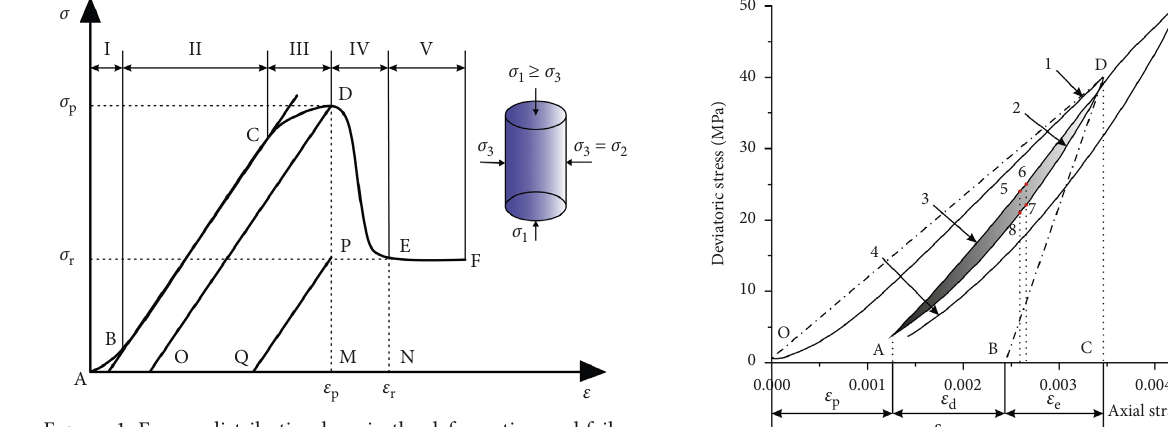
Figure 1: Energy distribution laws in the deformation and failure process of the